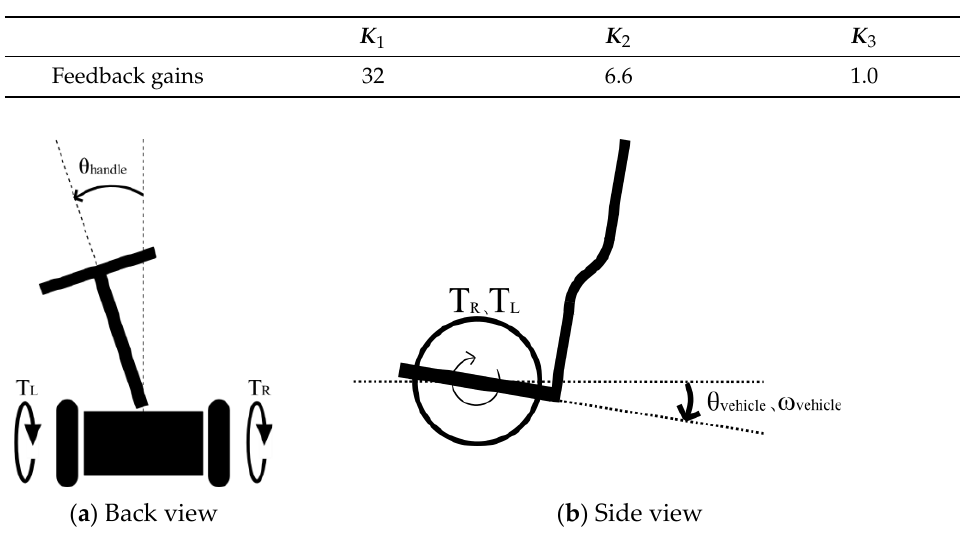
Table 2. Feedback gains for the experiments.